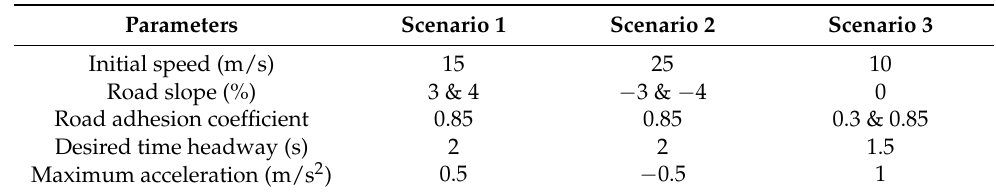
Table 3. Experimental condition parameter settings.